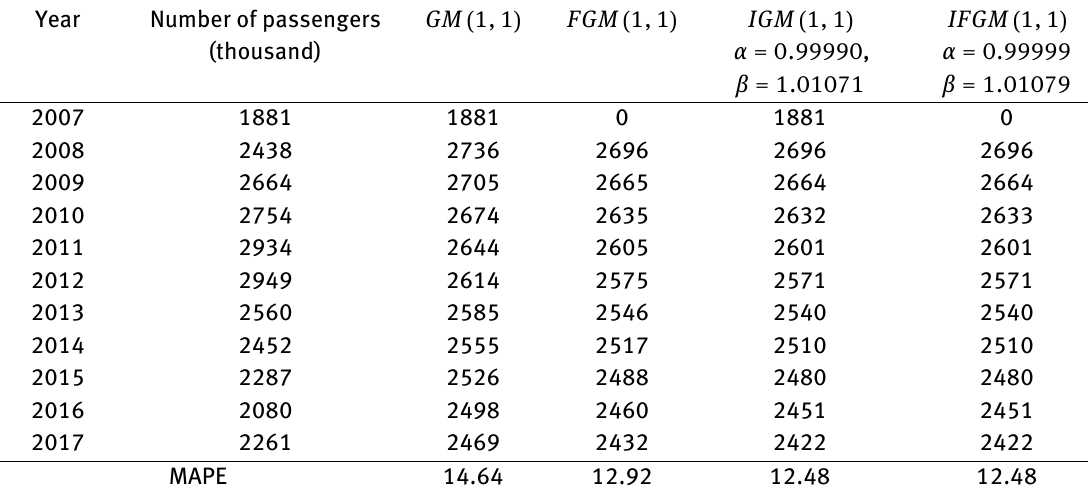
Table 3: The number of users of the public road transportation system: available data and the modeling results.